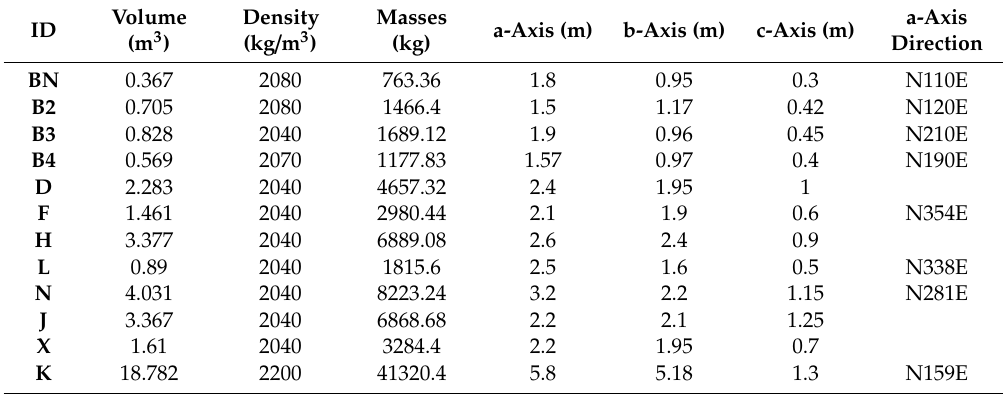
Table 1. Boulder features detected through photogrammetry surveys and laboratory analysis.